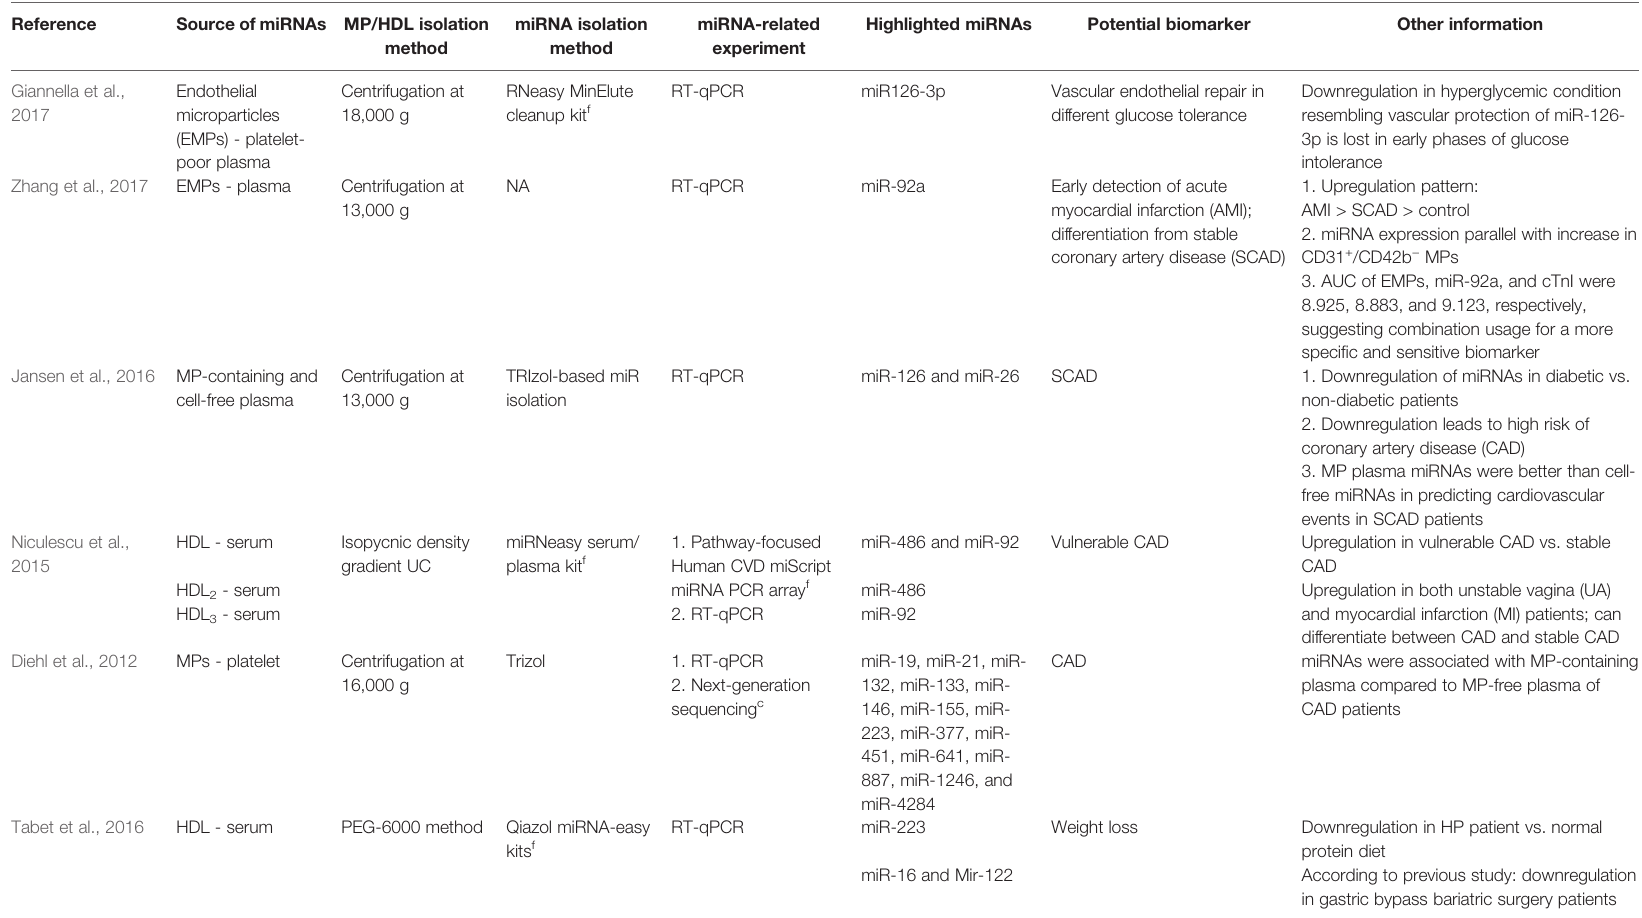
TABLE 1 | Summary of original articles involving non-exosomal circulating miRNAs as